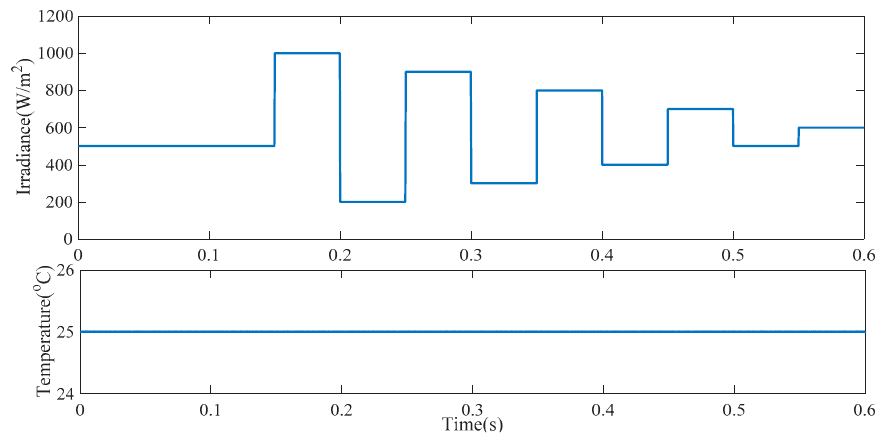
Figure 16. Temperature and irradiance variations in case 2.